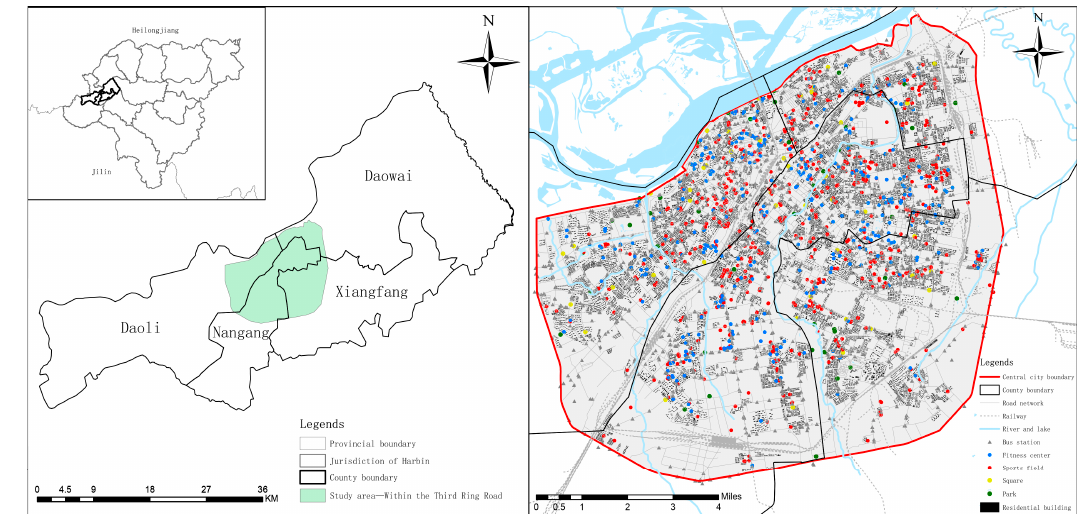
Figure 1. Study area and data examples.